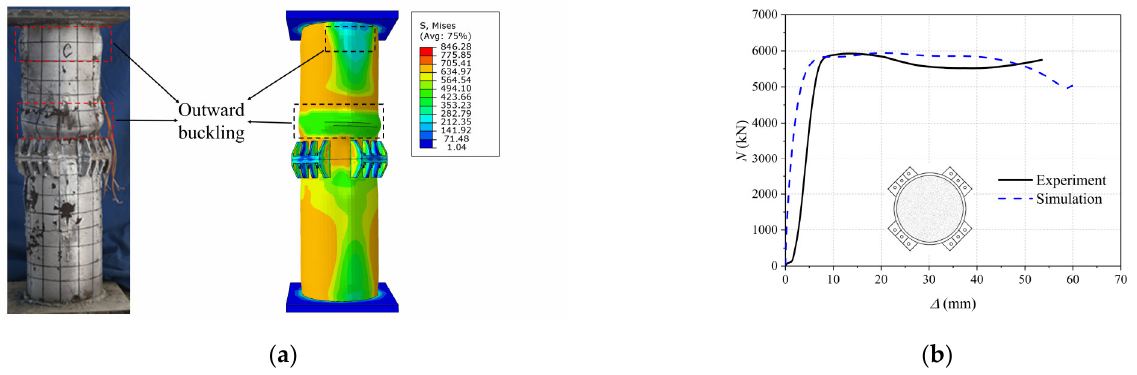
Figure 20. Comparison between experiment and simulation of normal BWCFST short column: ( a ) Failure mode; ( b ) N - curve.